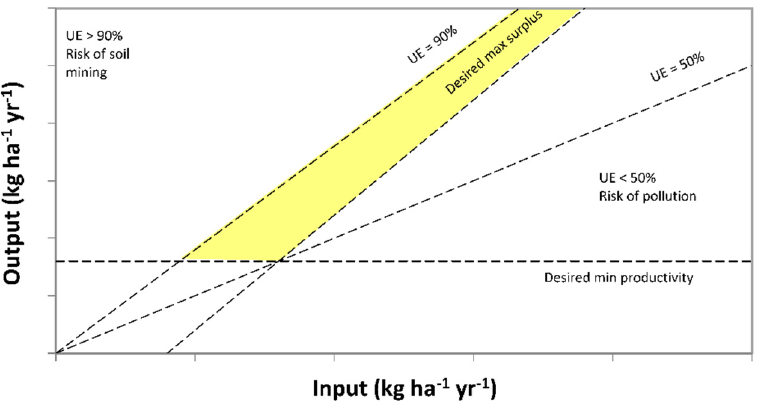
Figure 1. Graphical presentation of nutrient use efficiency (UE) using the results of the input vs. output diagram. The lines corresponding to nutrient UE = 0.90, desired maximum surplus, UE = 0.50, and desired minimum productivity create the “sustainability area” (in light yellow). The adopted graph is similar to what was reported by EU Nitrogen Expert Panel [13] for N.